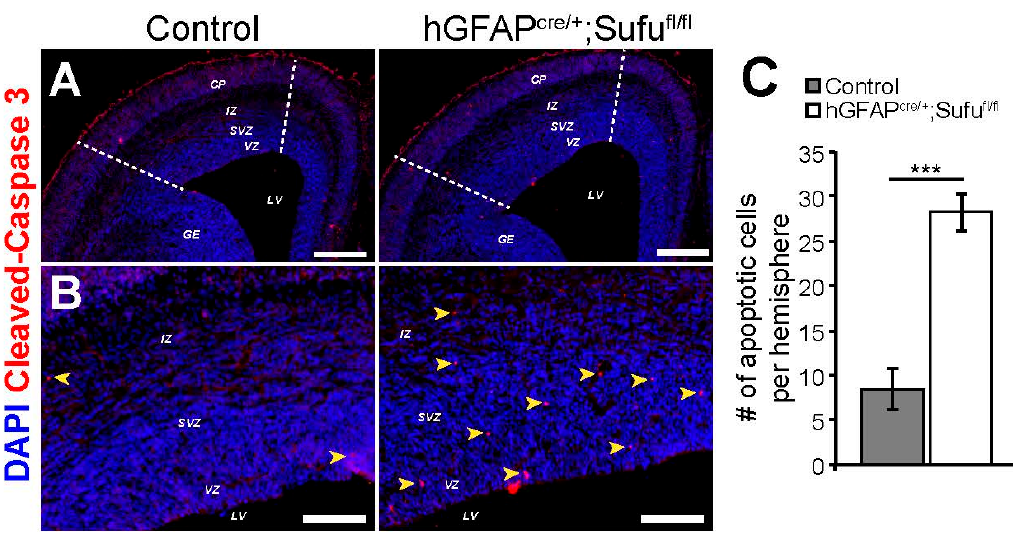
Figure 7. Increased cell death in the E16.5 hGFAP cre/+ ;Sufu fl/fl dorsolateral neocortex. ( A , B ) Immunostaining against the cell death marker, cleaved-Caspase 3 showed an increase in apoptotic cells within the dorsolateral neocortex (defined by dashed lines in A ); and as marked by yellow arrows in high magnification images ( B ); in the E16.5 hGFAP cre/+ ;Sufu fl/fl neocortex. Scale bars = 500 μ m ( A ); 100 μ m ( B ); ( C ) Quantification of cleaved-Caspase 3–positive cells in the dorsolateral region of the neocortical hemispheres confirmed the significant and dramatic increase in apoptotic cells in the E16.5 hGFAP cre/+ ;Sufu fl/fl neocortex compared to controls; *** p -value < 0.01.